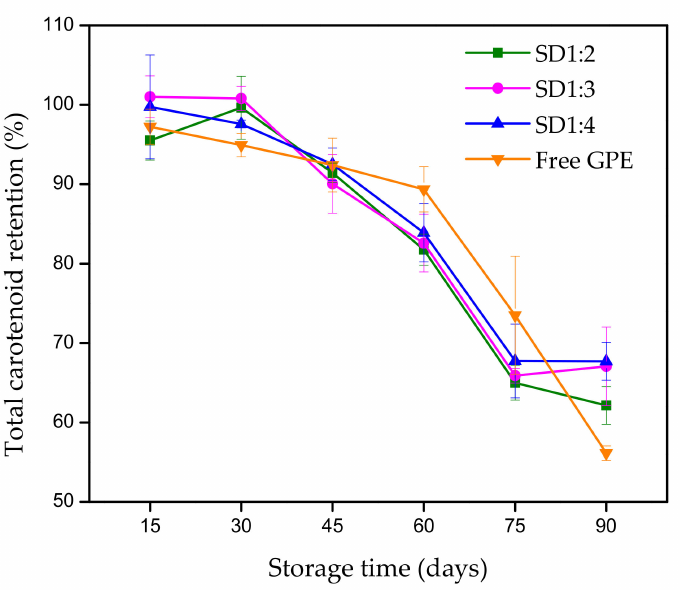
Figure 1. Total carotenoid retention in free and encapsulated guaran á peel extract (GPE) produced by spray drying at a temperature of 100 ◦ C. The formulations represent the proportion of the core:carrier